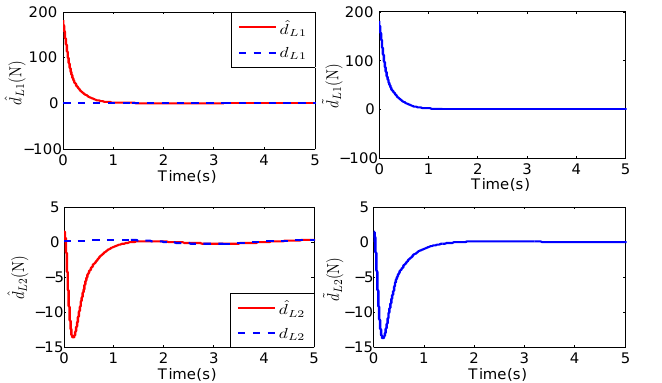
Figure 4. The MEHAs’ state errors of the two nodes in the simulation: x 11 cylinder position error; x 12 —the cylinder load pressure error.